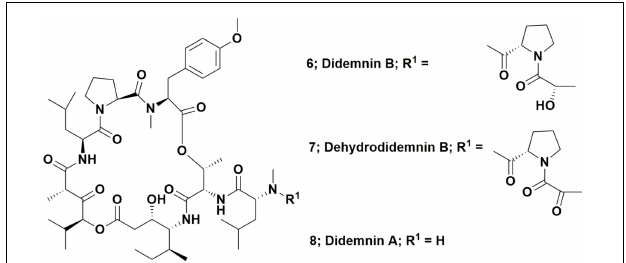
FIGURE 2 | Didemnin B and